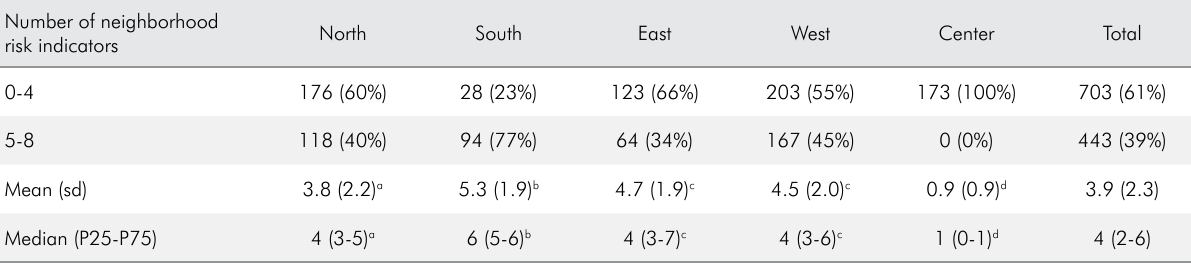
Table 3. Sample distribution according to the number of neighborhood risk indicators by city